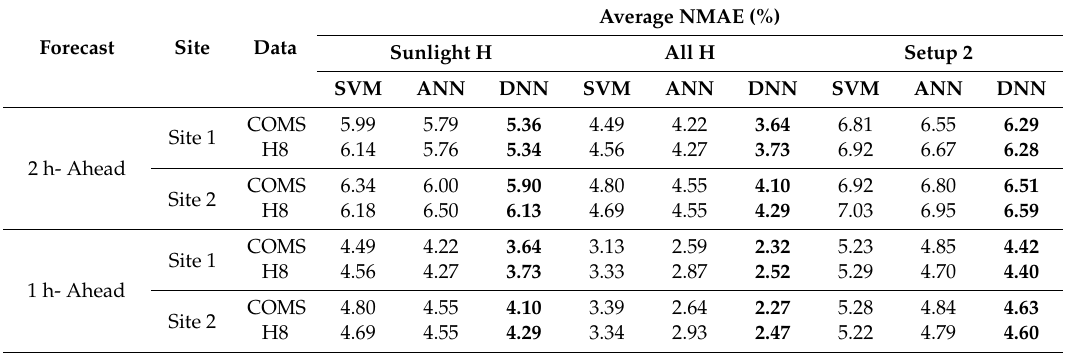
Table 11. Average NMAE results for 2 h- and 1 h-ahead forecasts from both setups organized with respect to the three forecast models (bold text indicates the lowest NMAE values for each model).